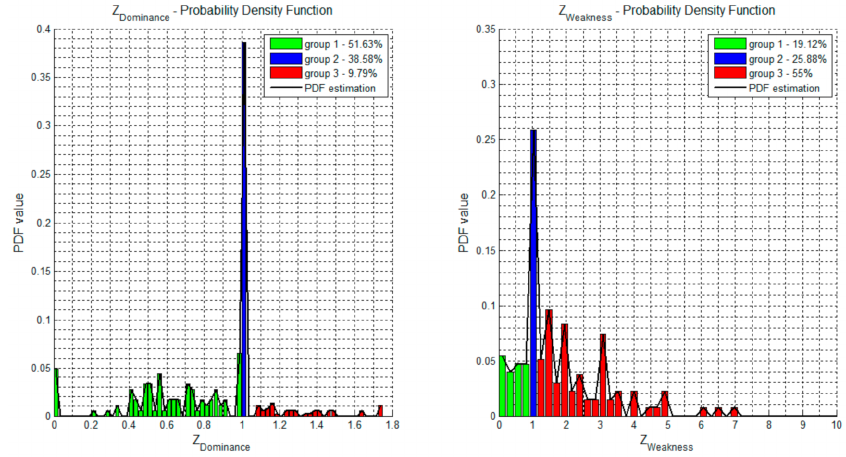
Figure A2. PDF of the preferences of players in dominant and weakness strategic